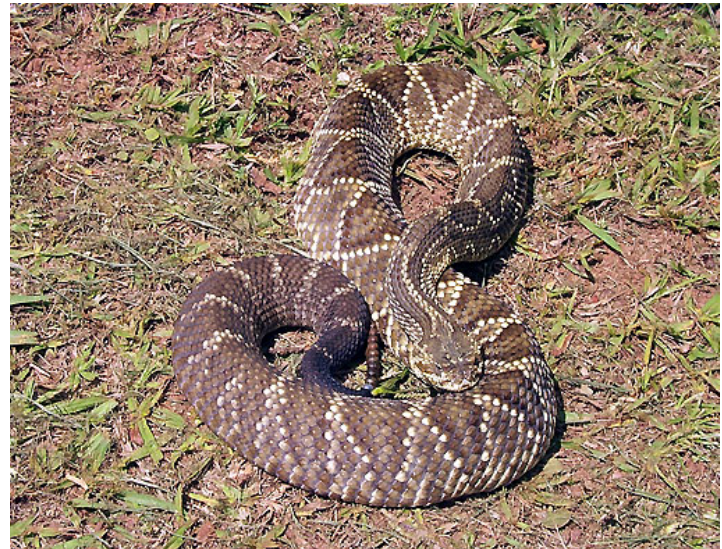
Figure 2. Crotalus durissus terrificus